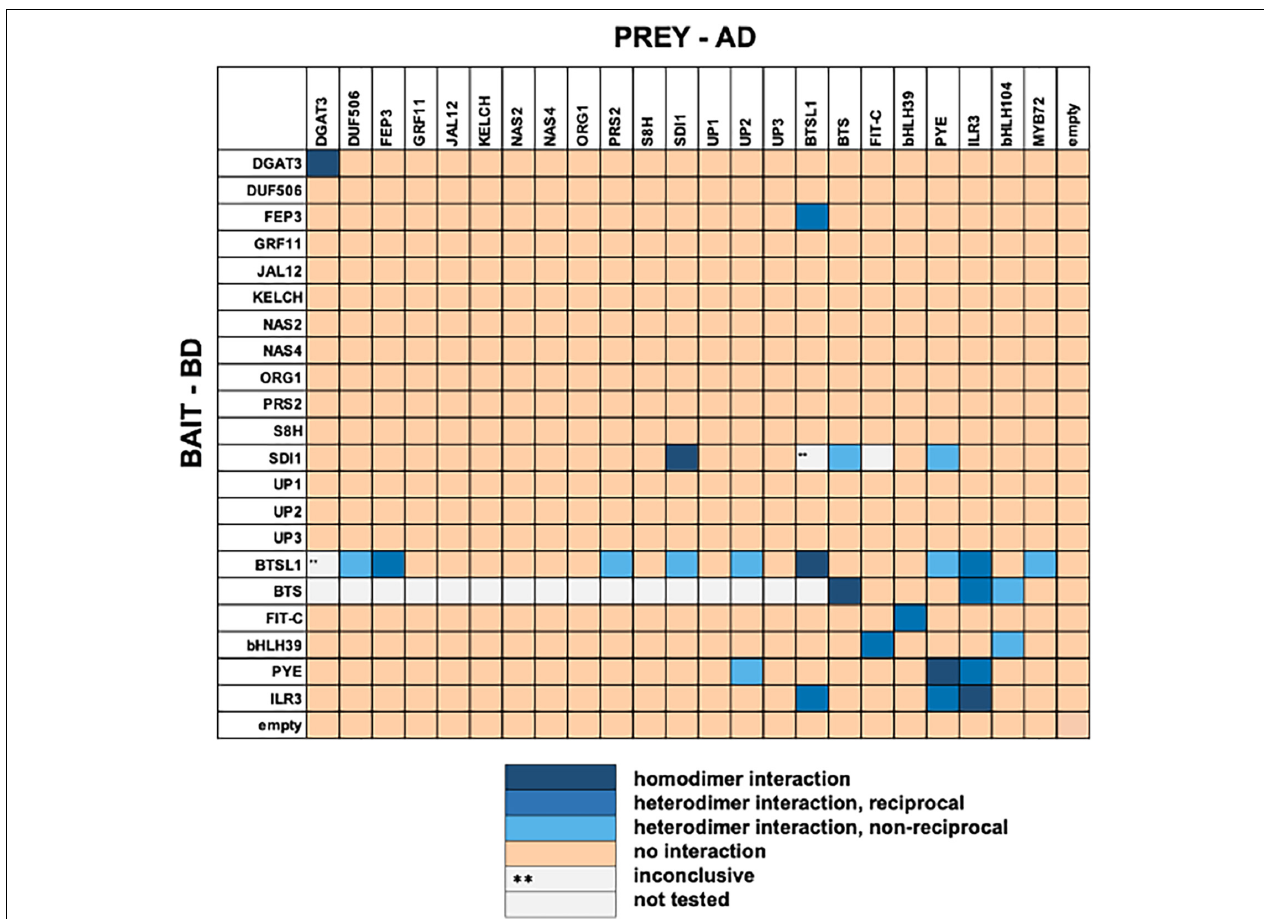
FIGURE 1 | Summary results of targeted yeast two hybrid (Y2H) screen. Twenty three protein candidates ( Supplementary Table 1 ) were tested reciprocally in pairwise combinations in a targeted Y2H screen. Bait protein was fused to the GAL4 DNA-binding domain (BD), prey protein to the GAL4 activation domain (AD). The color code distinguishes homodimeric interaction (dark blue), reciprocal heterodimeric interaction (middle blue), non-reciprocal heterodimeric interaction (light blue), no interaction (light orange) or inconclusive and non-tested interactions ( ∗∗ , light gray). bHLH104 and Myb72 were not included as bait because of autoactivation. FIT-C was included as it is not auto-activating (Gratz et al., 2020). Original data are presented in Supplementary Figures 1 , 2 .